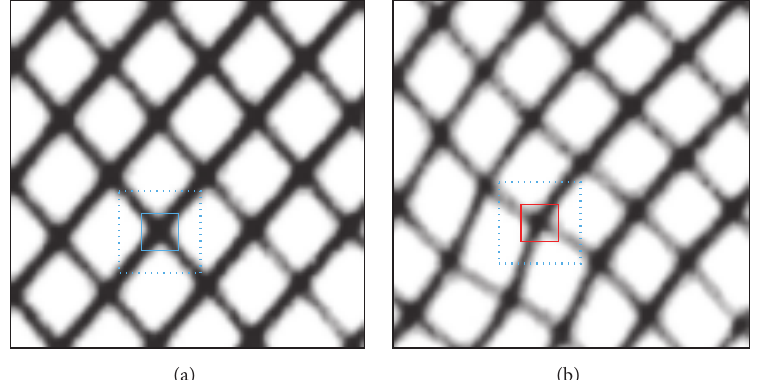
Figure 5: (a) and (b): undelayed and delayed MTV images, showing source (solid squares) and roam (dashed square) windows. Adapted from [35].